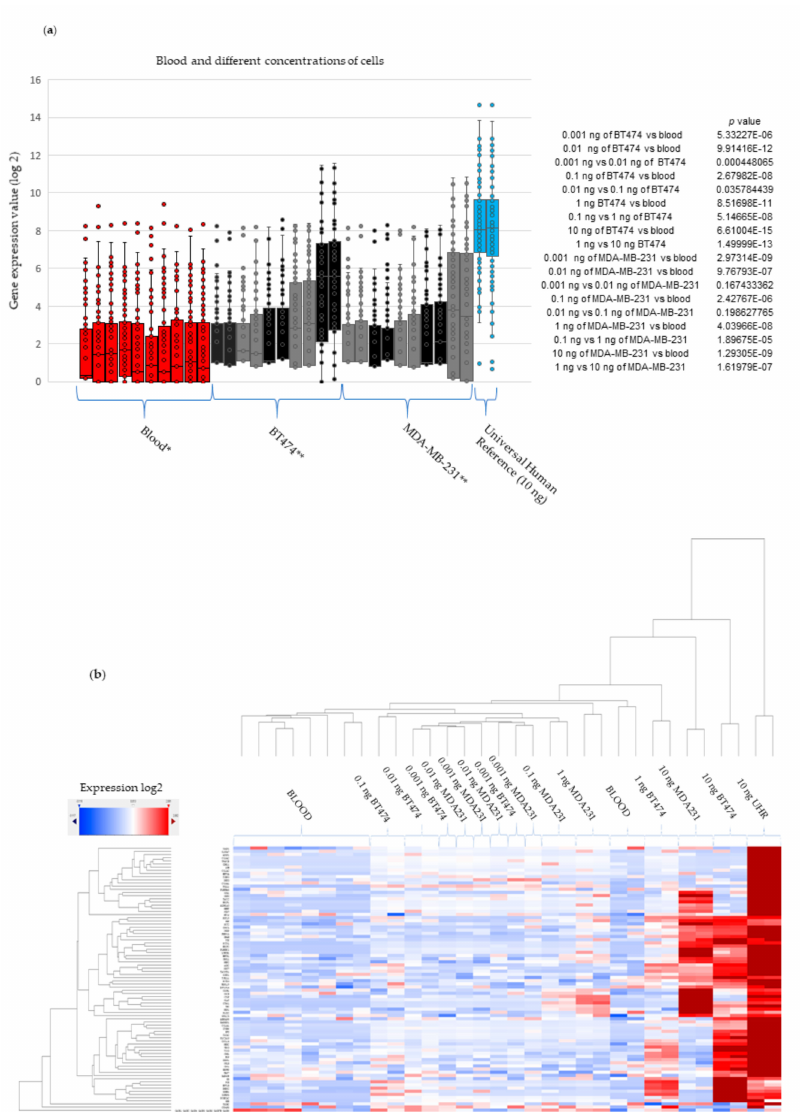
Figure 3. Experimental analysis with di ff erent concentrations of RNA from two breast cell lines diluted in pooled RNA from individuals with non-cancerous conditions. ( a ) Boxplots of the expression levels across the di ff erent dilution points. The boxplots show the expression levels for each cell analyzed (in duplicate), in order of increasing concentration, when mixed to a pool of 100 ng of blood RNA from cases with non-cancer conditions. It is possible to note that expression levels became expressive, when compared to blood, from 1 ng of RNA from the di ff erent lineages of breast cancer cells. ( b ) Heatmaps showing the expression levels across the di ff erent dilution points, showing expression distribution for each specimen analyzed. It is possible to note the increase in color intensity with increasing RNA concentration of the two breast cell lines tested in the pool of blood RNA from cases with conditions other than